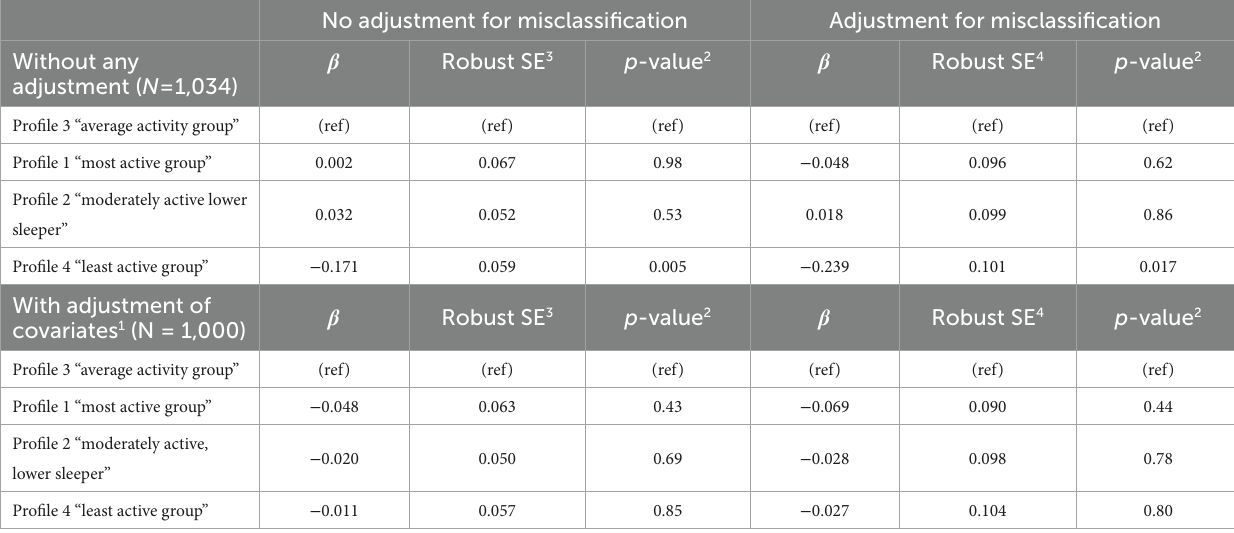
TABLE 5 Association of latent profiles with the outcome CASI-IRT score: without adjustment for the potential profile misclassification due to the uncertainty in latent profile assignment versus an approach that adjusted for the potential misclassification (improved BCH method).